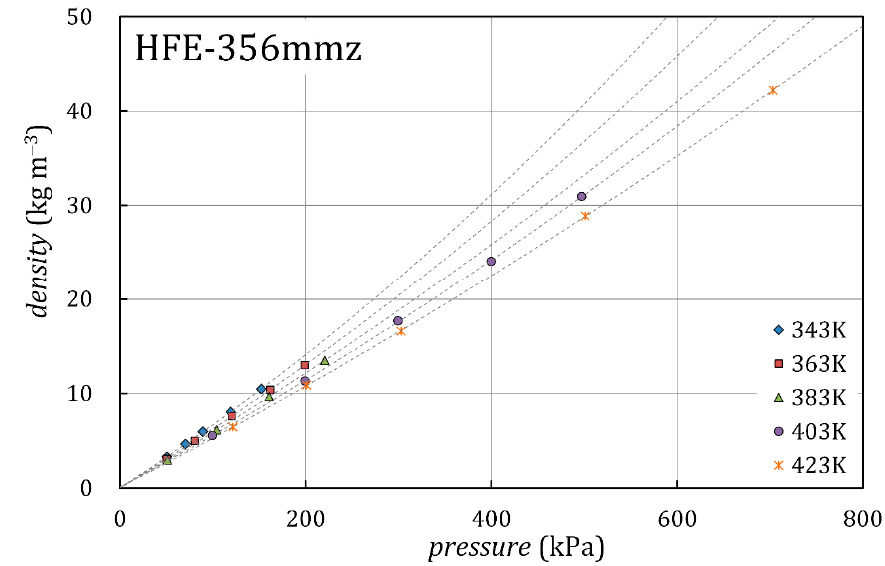
Figure 6. Density data on five isotherms for HFE-356mmz.